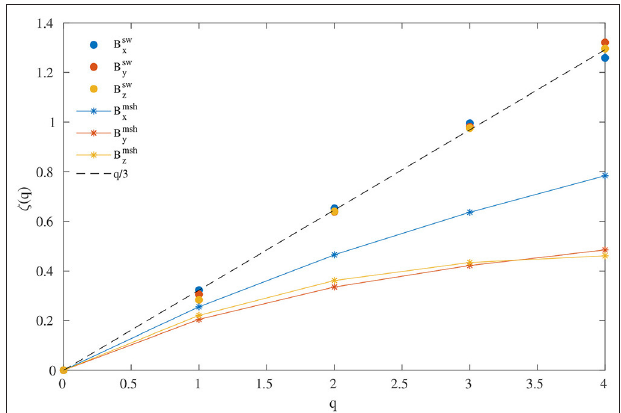
FIGURE 6 | Scaling exponents ζ ( q ) of the MHD range for the first Mercury flyby in the solar wind and the magnetosheath, respectively. Blue, orange, and yellow symbols refer to the magnetic field components. Filled circles correspond to the solar wind, while asterisks refer to the magnetosheath, respectively. The dashed black line refers to the theoretical scaling of q / 3 [